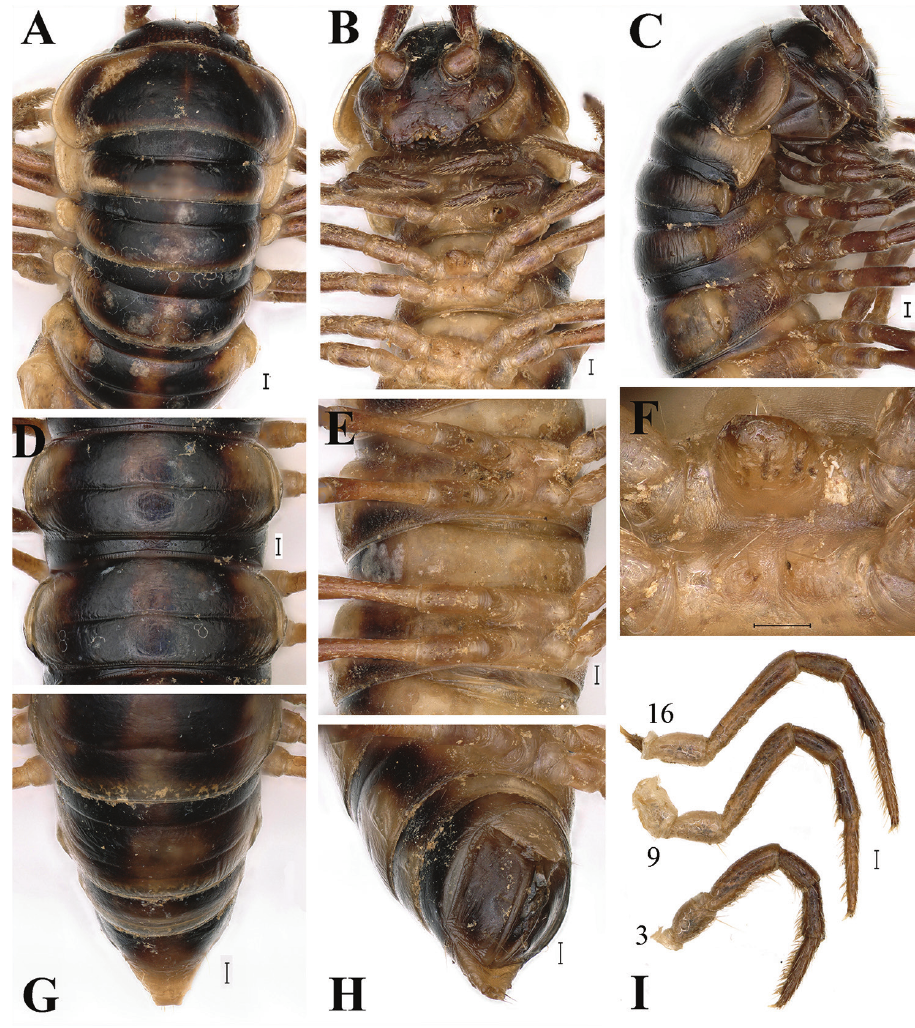
Figure 2. Tonkinosoma flexipes Jeekel, 1953, ♂ . A–C anterior part of body, dorsal, ventral and lateral views, respectively D, E midbody segments; dorsal and subventral views, respectively F sternite V, ventral view G, H posterior part of body, dorsal and ventrolateral views, respectively I legs 3, 9, 16, anterior views. Scale bar: 0.2